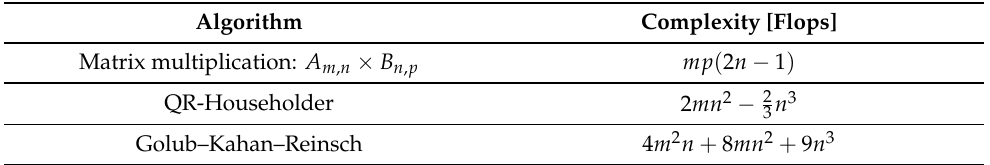
Table 2. Complexity of the algorithms evaluated.